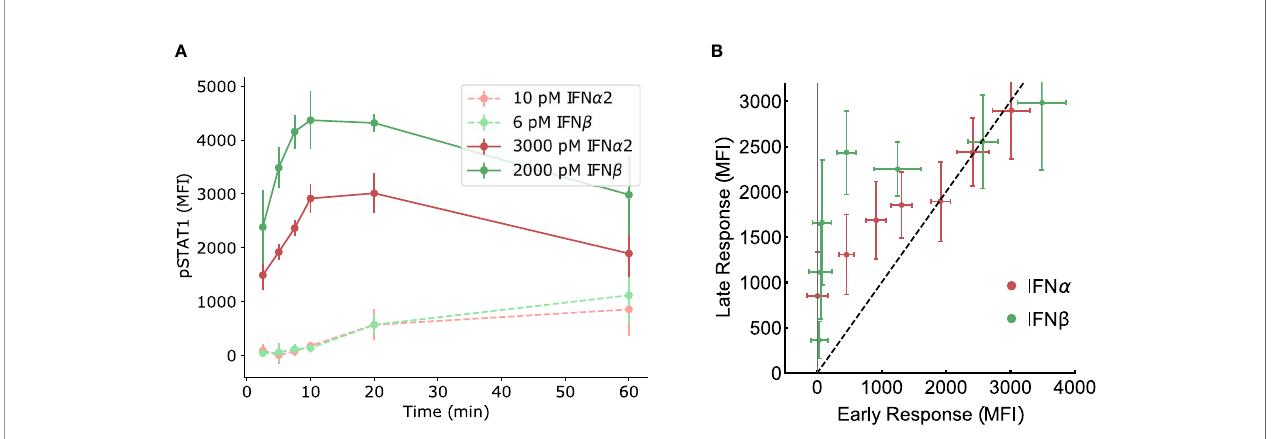
FIGURE 4 | No evidence of time-course signal discrimination. (A) The same experimentally measured data from mouse B cells presented in Figure 2D is re-plotted here as time courses for IFN a 2 and IFN b at comparably low (~10 1 pM) and high (~10 3 pM) doses. There is no apparent difference in the character (transient versus sustained) responses between IFN subtypes in either concentration regime. (B) The measured pSTAT response at early (5 minutes) and late (60 minutes) times, at equal concentrations, are plotted with the early-time response on the horizontal axis and late-time response on the vertical axis. A sustained response would produce points on the diagonal (black dashed line) while a transient response would produce points away from the diagonal. The points are not separable as transient versus sustained response based on the type of IFN, within the error